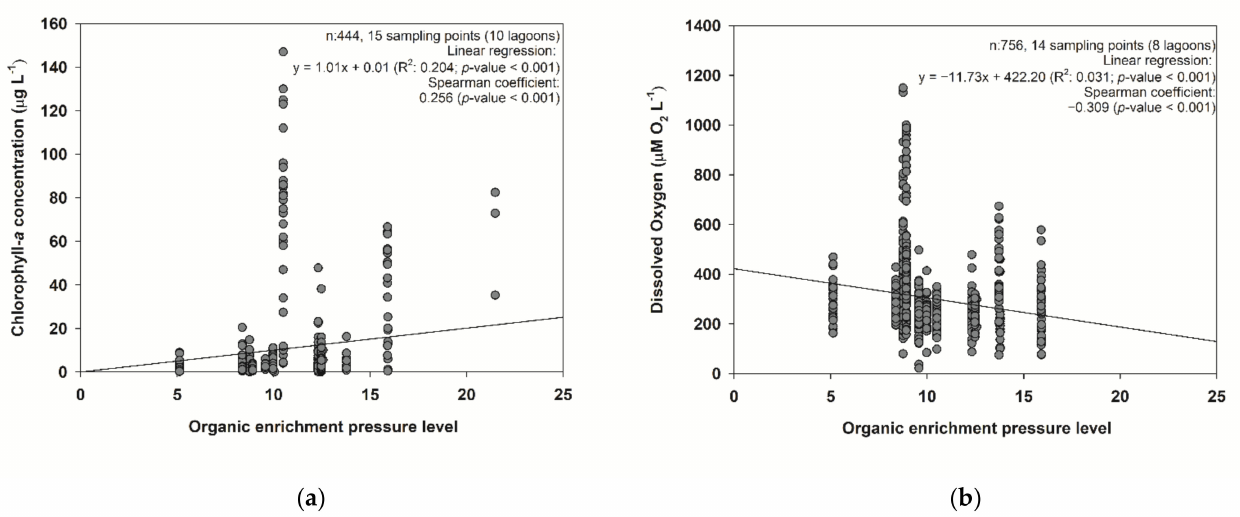
Figure 6. Relationship between organic enrichment pressure level with ( a ) Chl-a concentration, and ( b ) dissolved oxygen. Spearman coefficient (with the significance of the correlation), as well as linear regression (with the R 2 and significance of the regression model) are